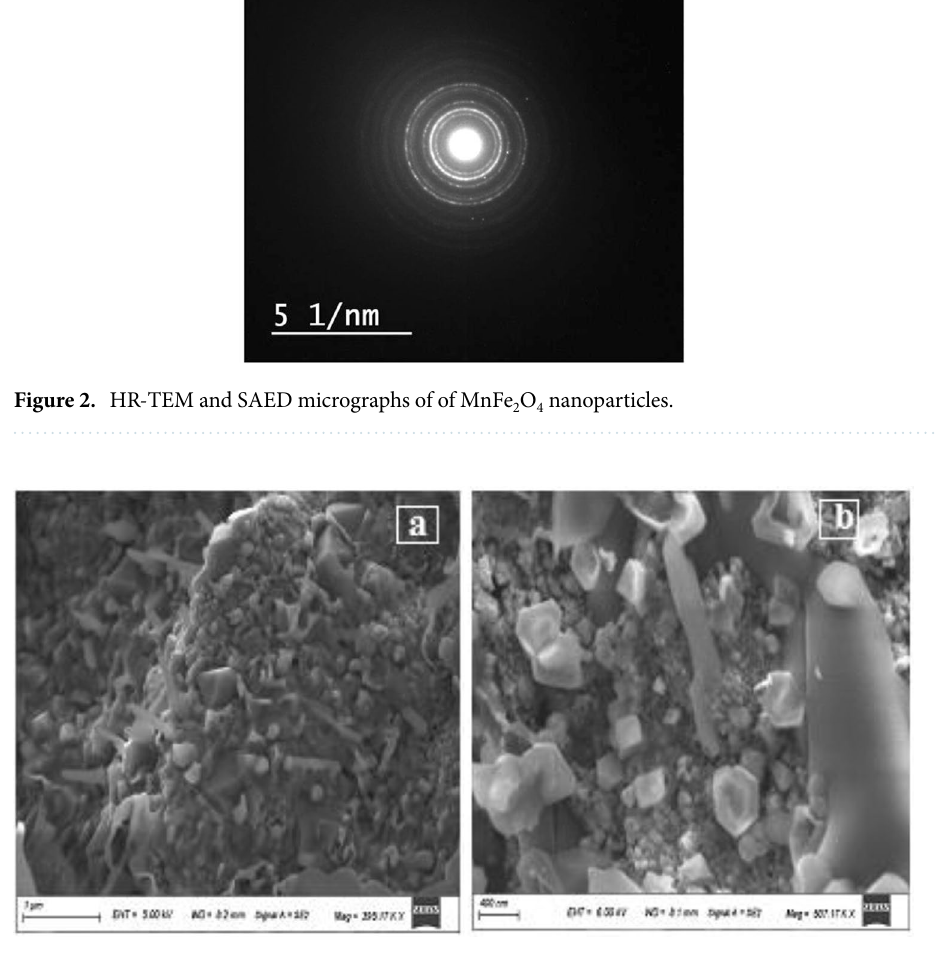
Figure 3. SEM of MnFe 2 O 4